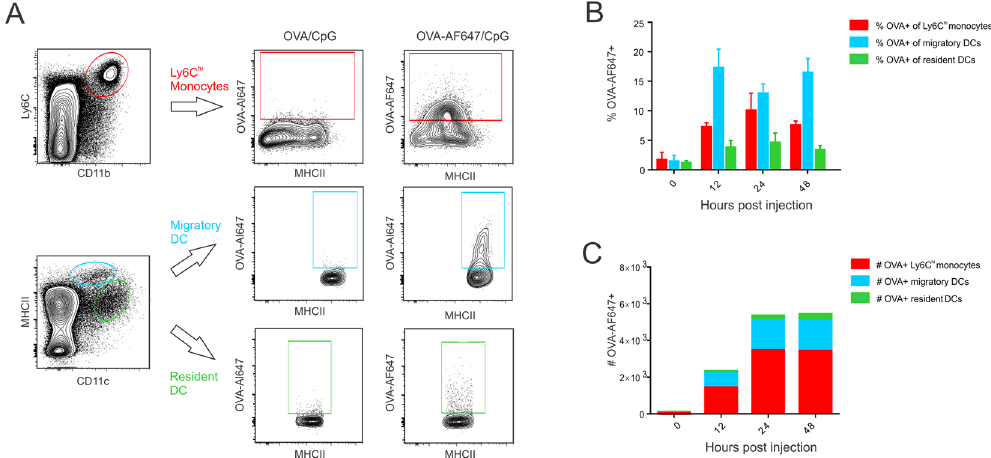
Figure 4. Antigen uptake by monocytes, migratory DCs and resident DCs in lymph nodes, ( A ) Gating strategy applied to identify OVA-AF647 + Ly6C hi monocytes, migratory DCs and resident DCs in the draining lymph nodes of OVA-AF647/CpG injected mice. ( B , C ) Graphs showing respectively the percentages ( B ) and absolute numbers ( C ) of Ly6C hi monocytes, migratory DCs and resident DCs that have acquired OVA-AF647 in the draining lymph nodes at the indicated time intervals post OVA-AF647 injection (n = 4). Data are representative of three independent